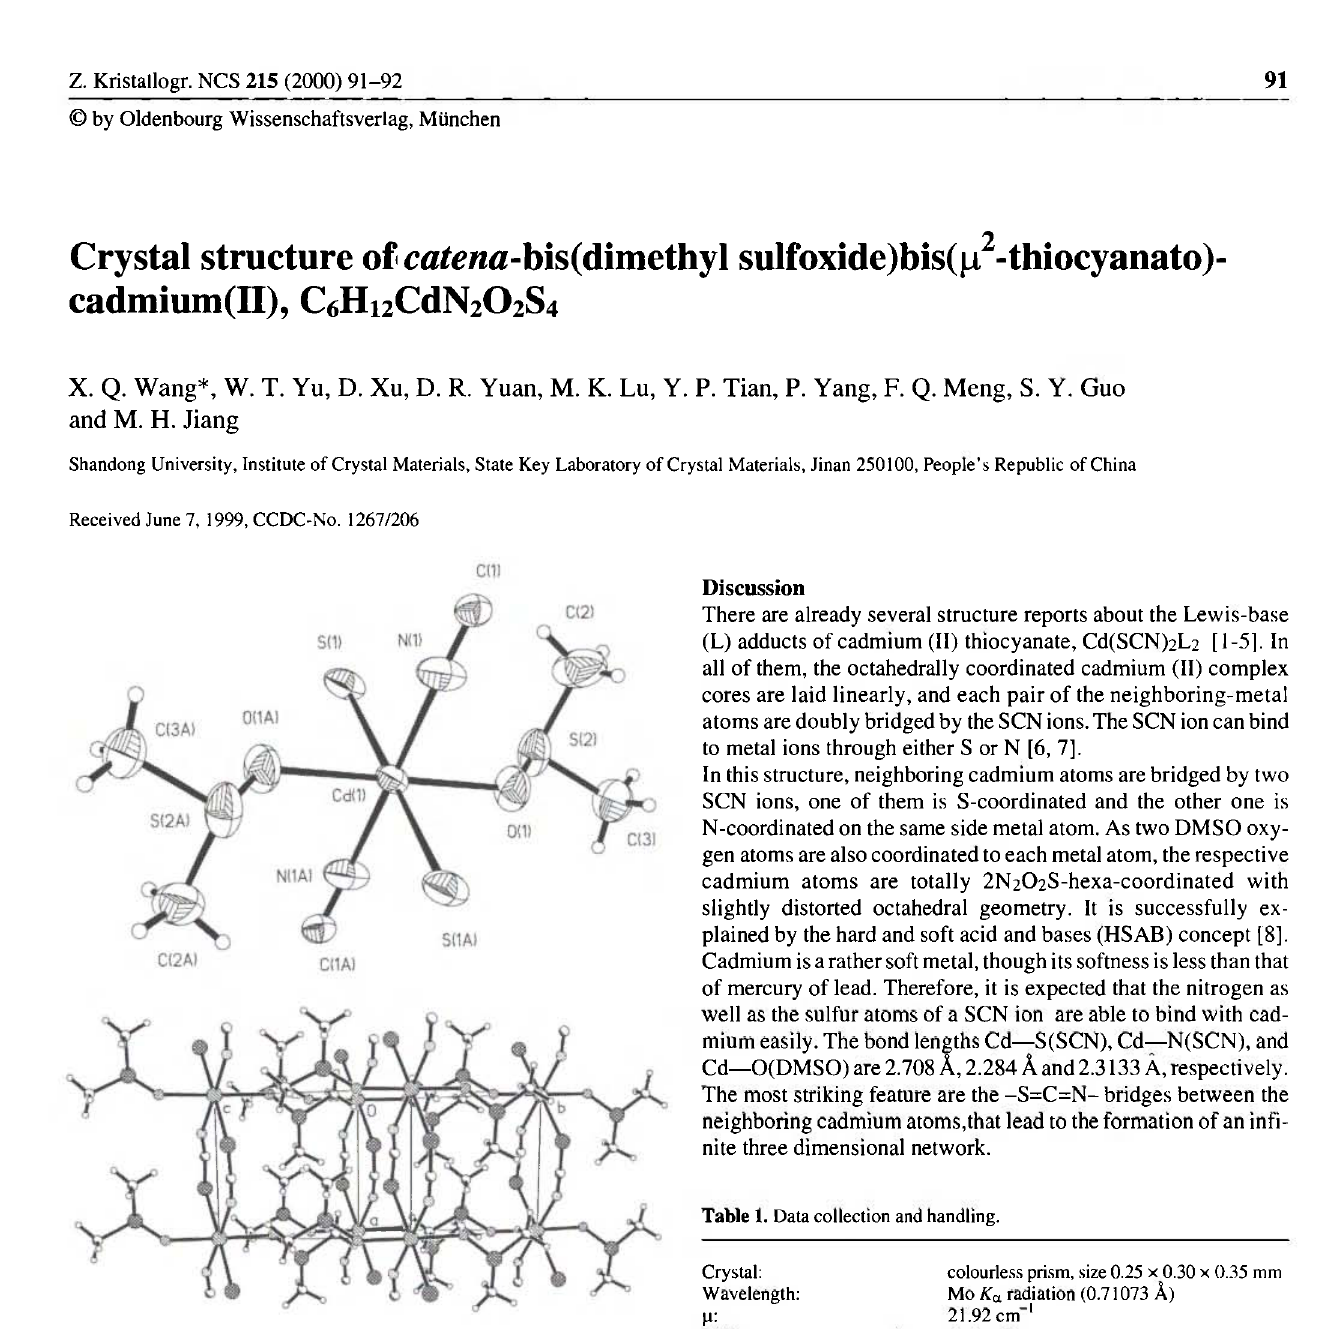
Table 1. Data collection and handling.